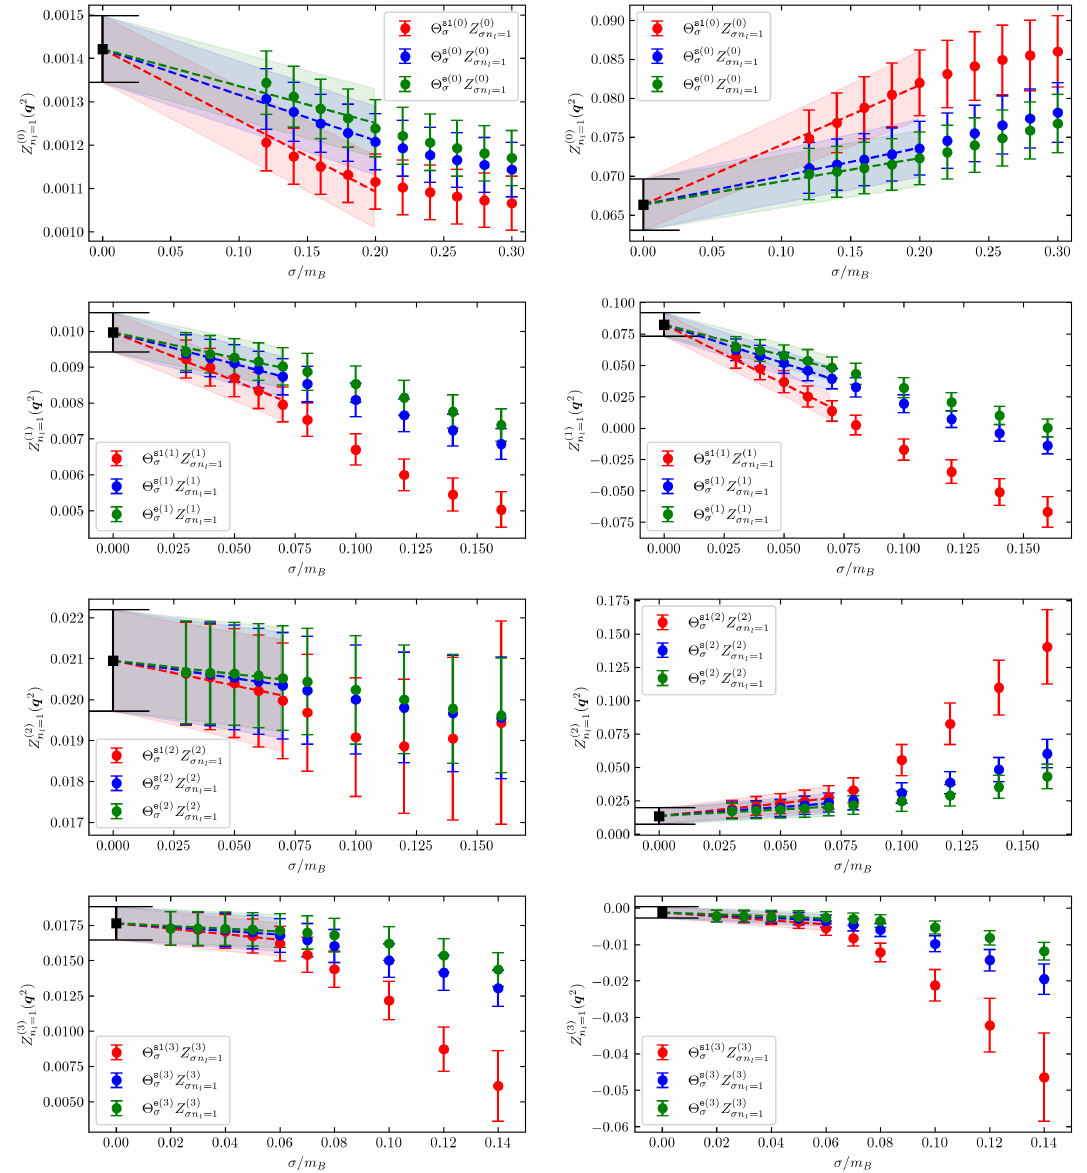
Figure 13 . Combined σ → 0 extrapolations of the four contributions Z ( l ) moment, see eq. (2.45). The plots on the left correspond to | q | ’ 0 . 26 GeV while those on the right to | q | ’ 0 . 78